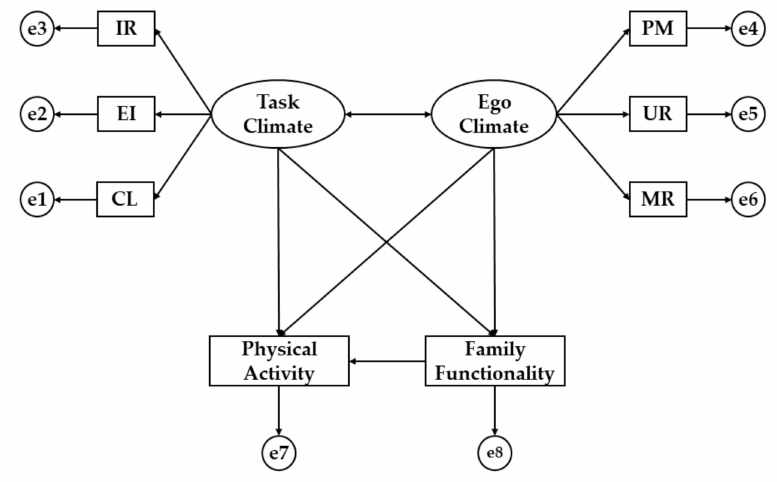
Figure 1. Theoretical Model. Note: IR, important role; EI, e ff ort / improvement; CL, cooperative learning; PM, punishment for mistakes; UR, unequal recognition; MR, member